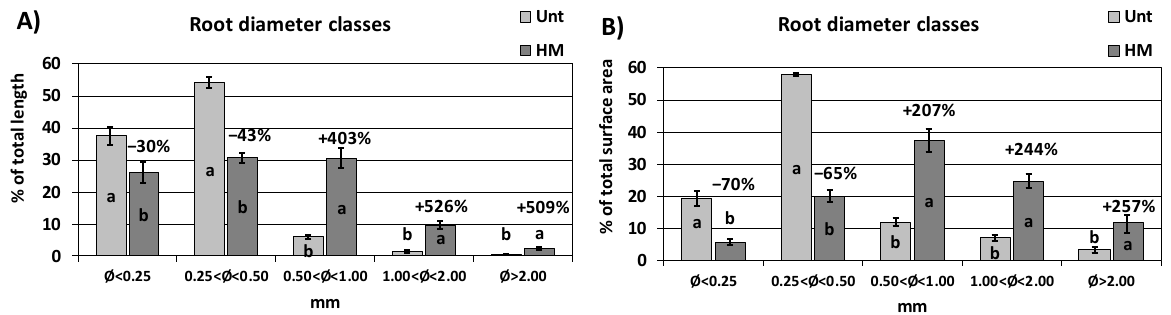
Figure 3. Percentages of root length ( A ) and surface area ( B ), according to different diameter ( Φ ) classes, i.e., <0.25, 0.25–0.50, 0.5–1.0, 1–2, >2 mm (± SE; n = 4), of the maize hybrid Naudi grown for 41 days in uncontaminated (Unt) vs. metal contaminated (HM) soil. Numbers above the histograms refer to the % variations vs. Unt. Letters indicate significant differences between treatments in the same diameter interval (Newman–Keuls test, p ≤ 0.05).